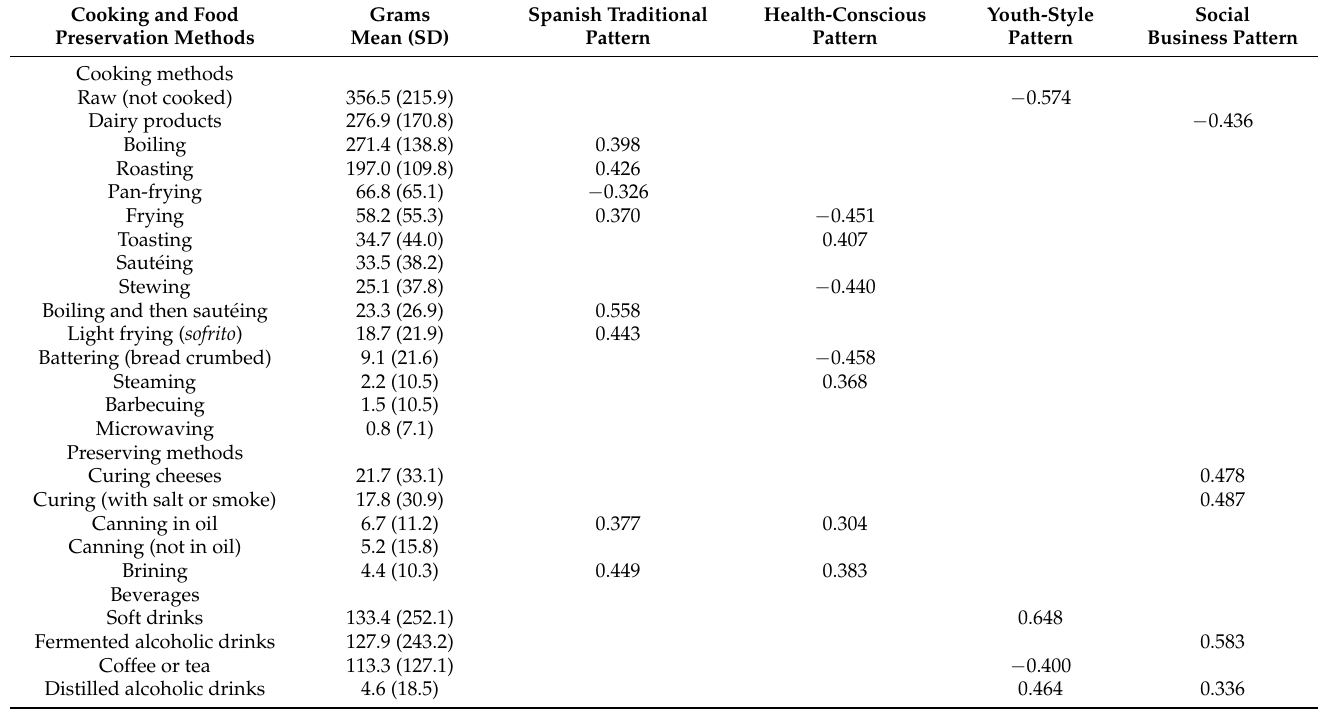
Table 1. Varimax-rotated factor-loading matrix obtained using factor analysis.